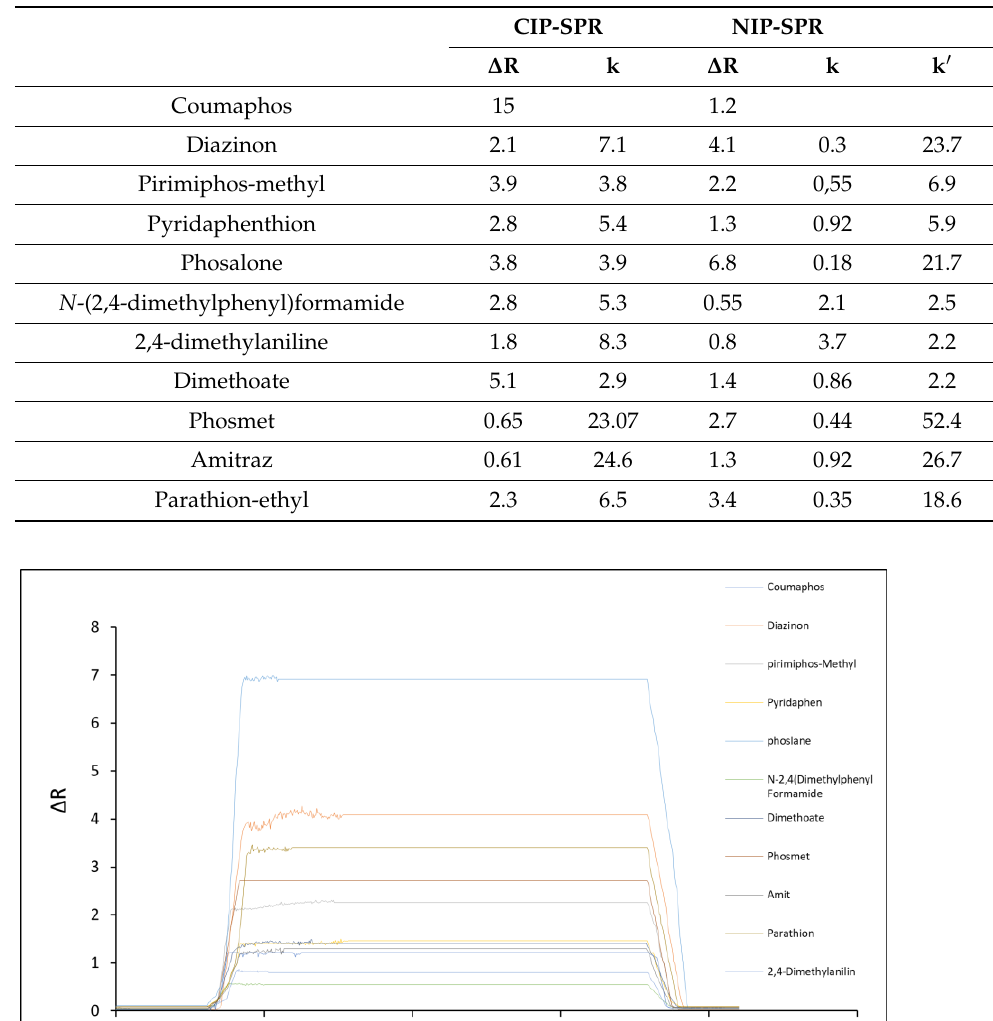
Table 3. Selectivity coefficient.